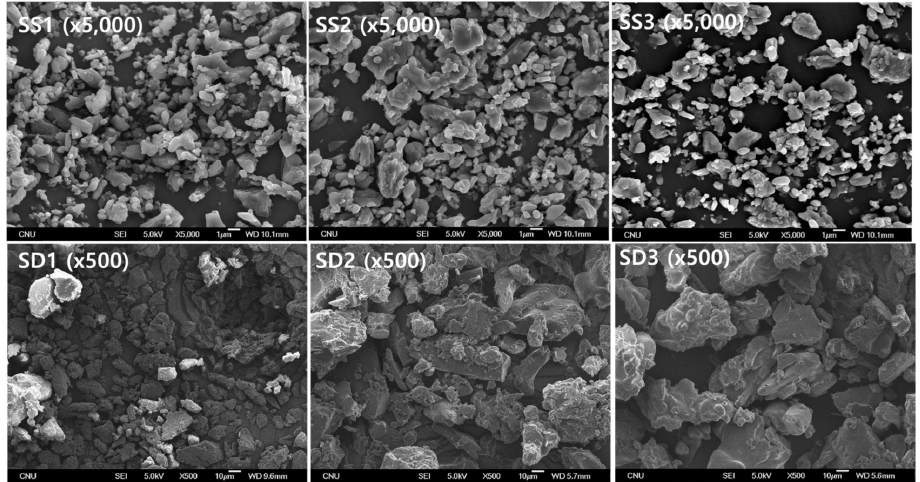
Figure 3. The SEM micrographs obtained by two different particle formation processes, including the SA-SD process ( upper ) and the SD process ( lower